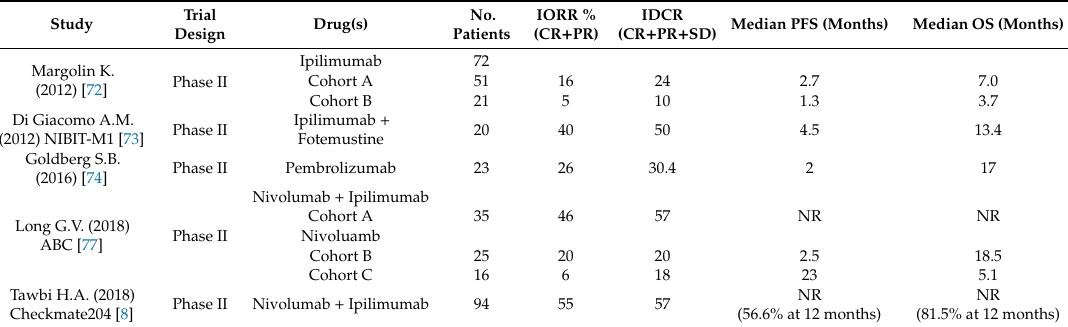
Table 3. Prospective study of Immunotherapy in melanoma with brain